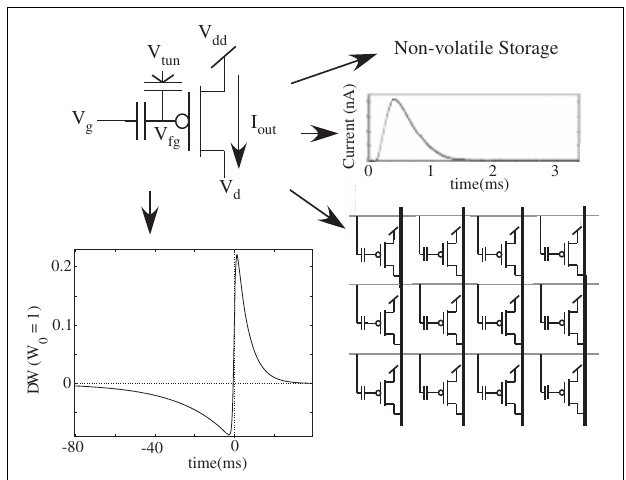
FIGURE 5 | A single transistor synapse device is presented and architecture that uses non-volatile storage, generates biological post-synaptic potential (PSP) outputs, can easily be arrayed in a mesh architecture, and demonstrates biological synapse learning rules, such as long term potentiation (LTP), long term depression (LTD), and spike time dependent plasticity